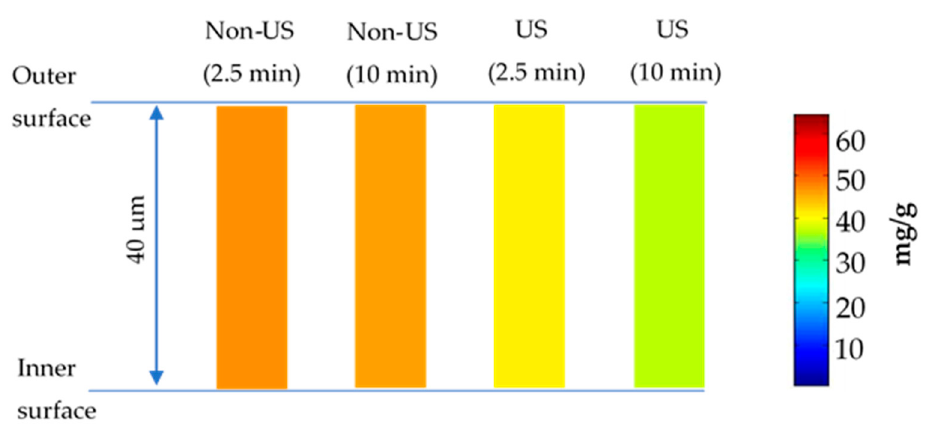
Figure 6. Distribution of phenolics within almond skins during extraction.